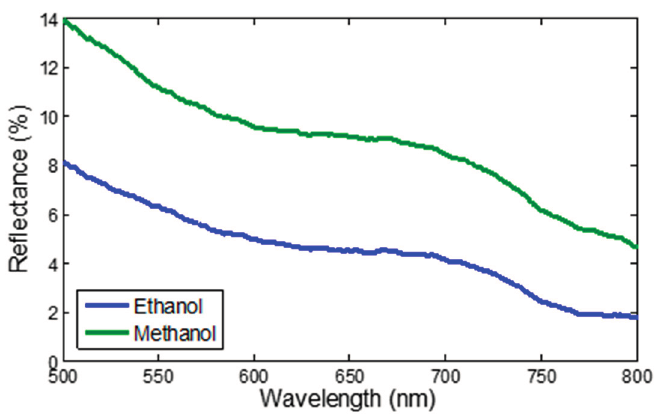
Figure 11. Reflectance response of tapered fiber coated with CNT towards pure methanol and